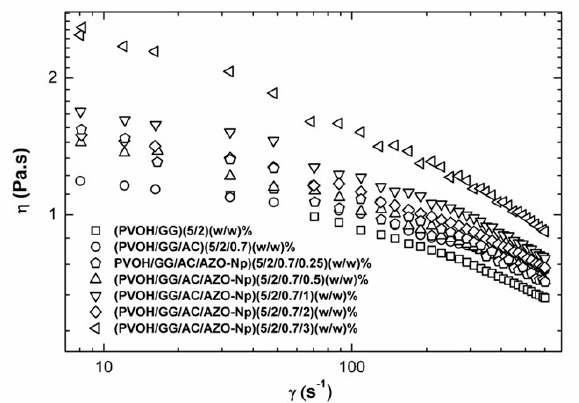
. Figure 7. Flow curve (viscosity ( η ) x shear rate ( γ )) for the samples with AZO-Np in different Figure 7. Flow curve (viscosity ( η ) x shear rate ( 𝛾(cid:4662) )) for the samples with AZO-Np in different concentrations and the controls PVOH/GG and PVOH/GG/CA. concentrations and the controls PVOH/GG and